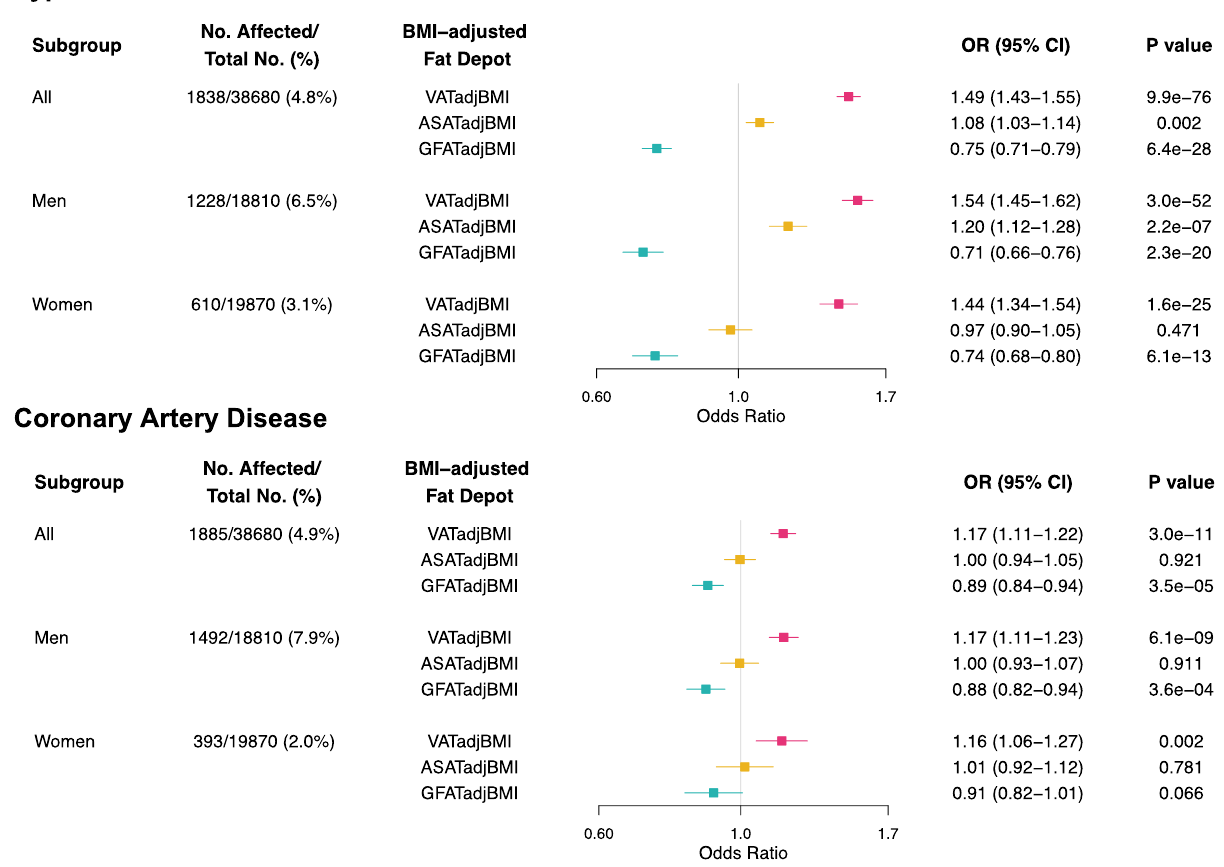
adjusted for age, sex (except in sex subgroup analyses), BMI, the other two fat depots (e.g. ASATadjBMI and GFATadjBMI for VATadjBMI), and MRI imaging cen- ter. Source data are provided as a Source Data fi le. Abbreviations: VATadjBMI, visceral adipose tissue adjusted for body mass index (BMI); ASATadjBMI, abdom- inal subcutaneous adipose tissue adjusted for BMI; GFATadjBMI, gluteofemoral adipose tissue